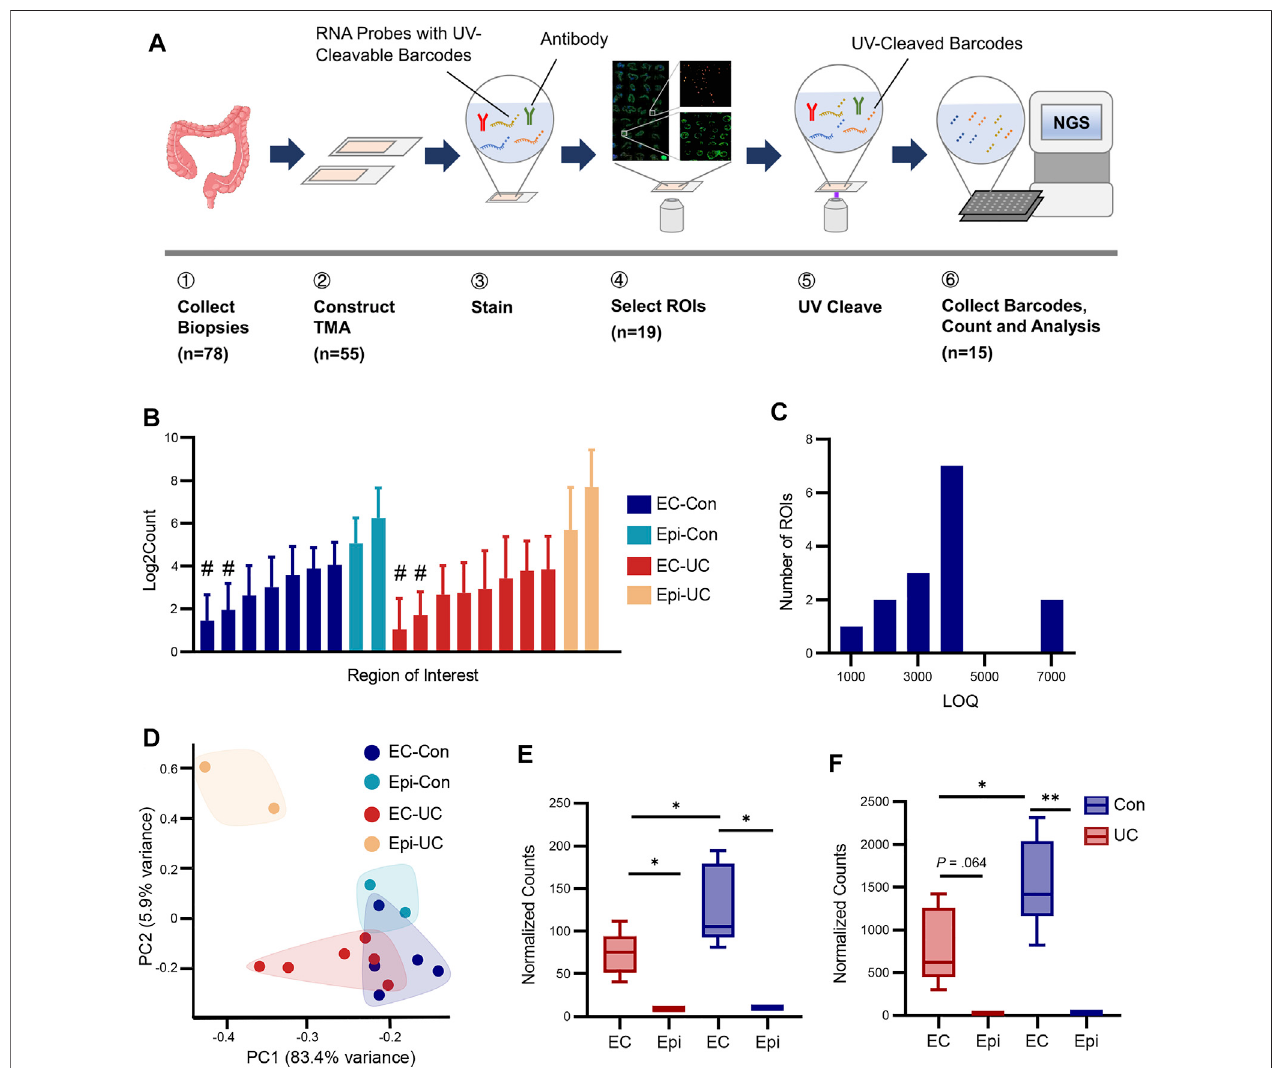
FIGURE 1 | Digital spatial pro fi ling of EC cells from human colon biopsy. (A) Schematic work fl ow of digital spatial pro fi ling. Biopsy specimens were collected and assembledintoTMAs.Thesectionswereincubatedwithimmuno fl uorescenceantibodies(forcelltypeidenti fi cation)andRNAprobeswithUC-cleavablebarcodes.After ROIselection,barcodeswithineachROIwerecleavedfromprobesbya fi nebeamofUVrayandcollectedforNGSsequencing. (B) Averagerawcountoftargetsineach ROI. The y -axis was log2-transformed. EC-Con, EC cells from healthy participants; Epi-Con, epithelium (excluding EC) from healthy participants; EC-UC, EC cells from patients with ulcerative colitis; Epi-UC, epithelium from patients with UC. # indicates QC failure. (C) To determine how many genes were detected in each ROI, the number oftargets above the limit ofquanti fi cation (LOQ) in each ROI wascalculated. (D) Principal componentanalysis (PCA) ofROIs from each group. (E,F) Expression levels of TPH1 and CHGA . Differences between groups were analyzed using Student ’ s t -test (two-tailed). * p < 0.05 and ** p < 0.01.